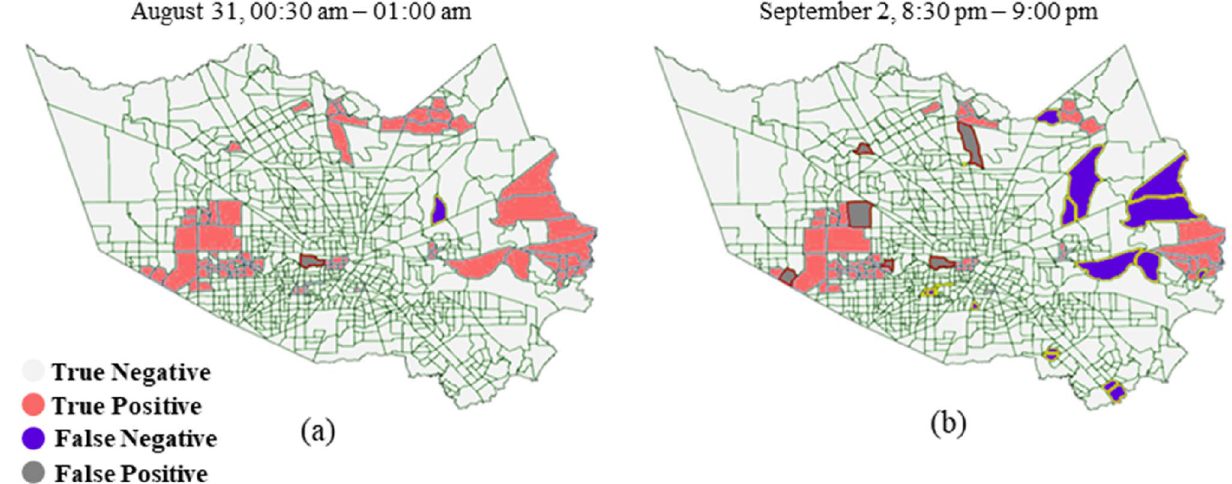
Figure 6. An example of model flood nowcasting performance; ( a ) a proper prediction (August 31, 00:30 a.m.–01:00 a.m.) versus ( b ) model prediction with more misclassification (September 2, 8:30 p.m.–9:00